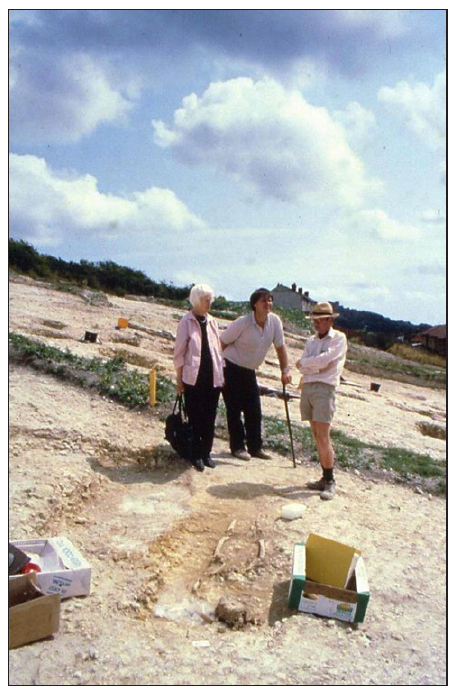
Figure 2: Vera Evison (left) at the excavations at Dover Buckland, Kent (Photo: Keith